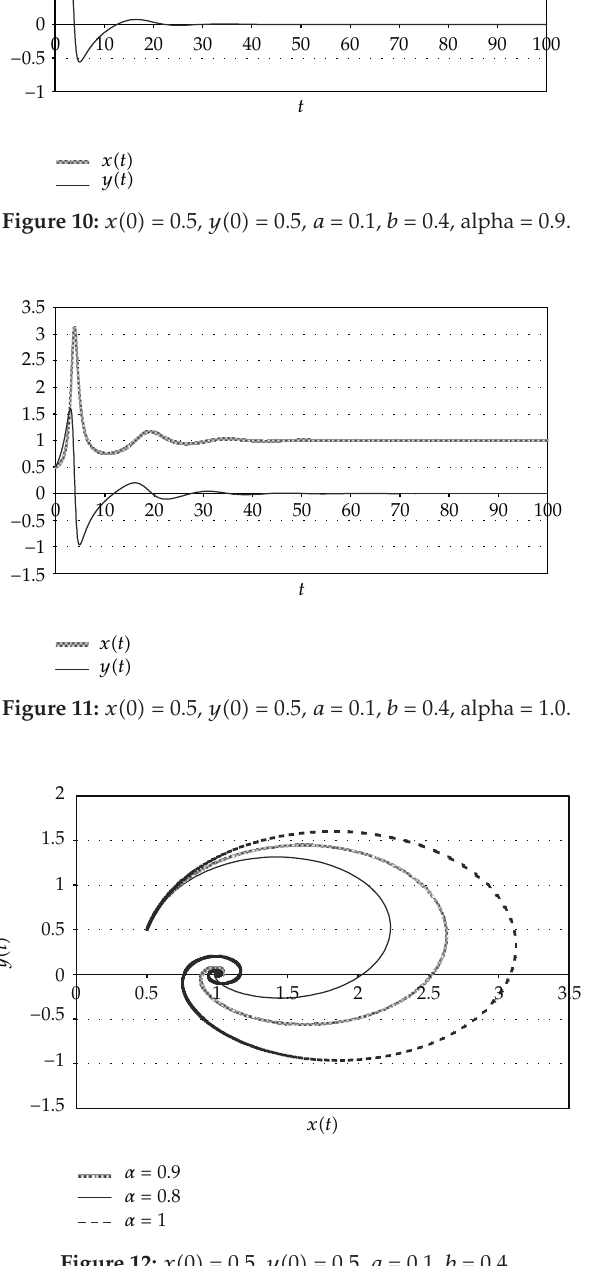
Figure 12: x (cid:2) 0 (cid:3) (cid:6) 0.5, y (cid:2) 0 (cid:3) (cid:6) 0.5, a (cid:6) 0.1, b (cid:6)